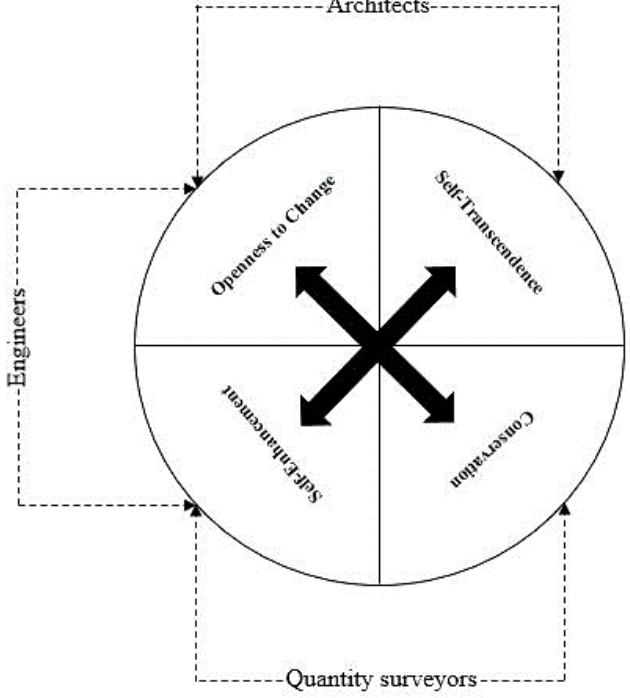
Figure 4: The perceived trends of professions regarding the 4 higher-order value